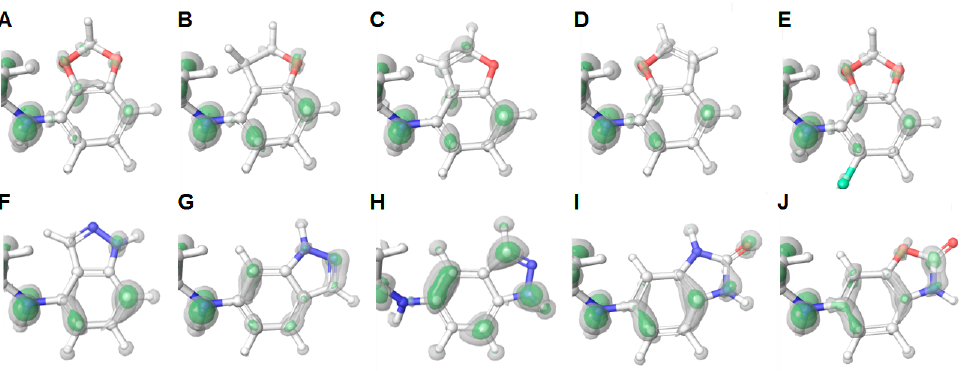
Figure 7. Electronic mapping of the scaffolds showing Fuikui minus visualized with two isovalues, 0.002 (white) and 0.004 (green): ( A ) 9 , ( B ) 17 , ( C ) 19 , ( D ) 20 , ( E ) 14 , ( F ) 32 , ( G ) 35 , ( H ) 37 , ( I ) 39 , ( J ) 40 .